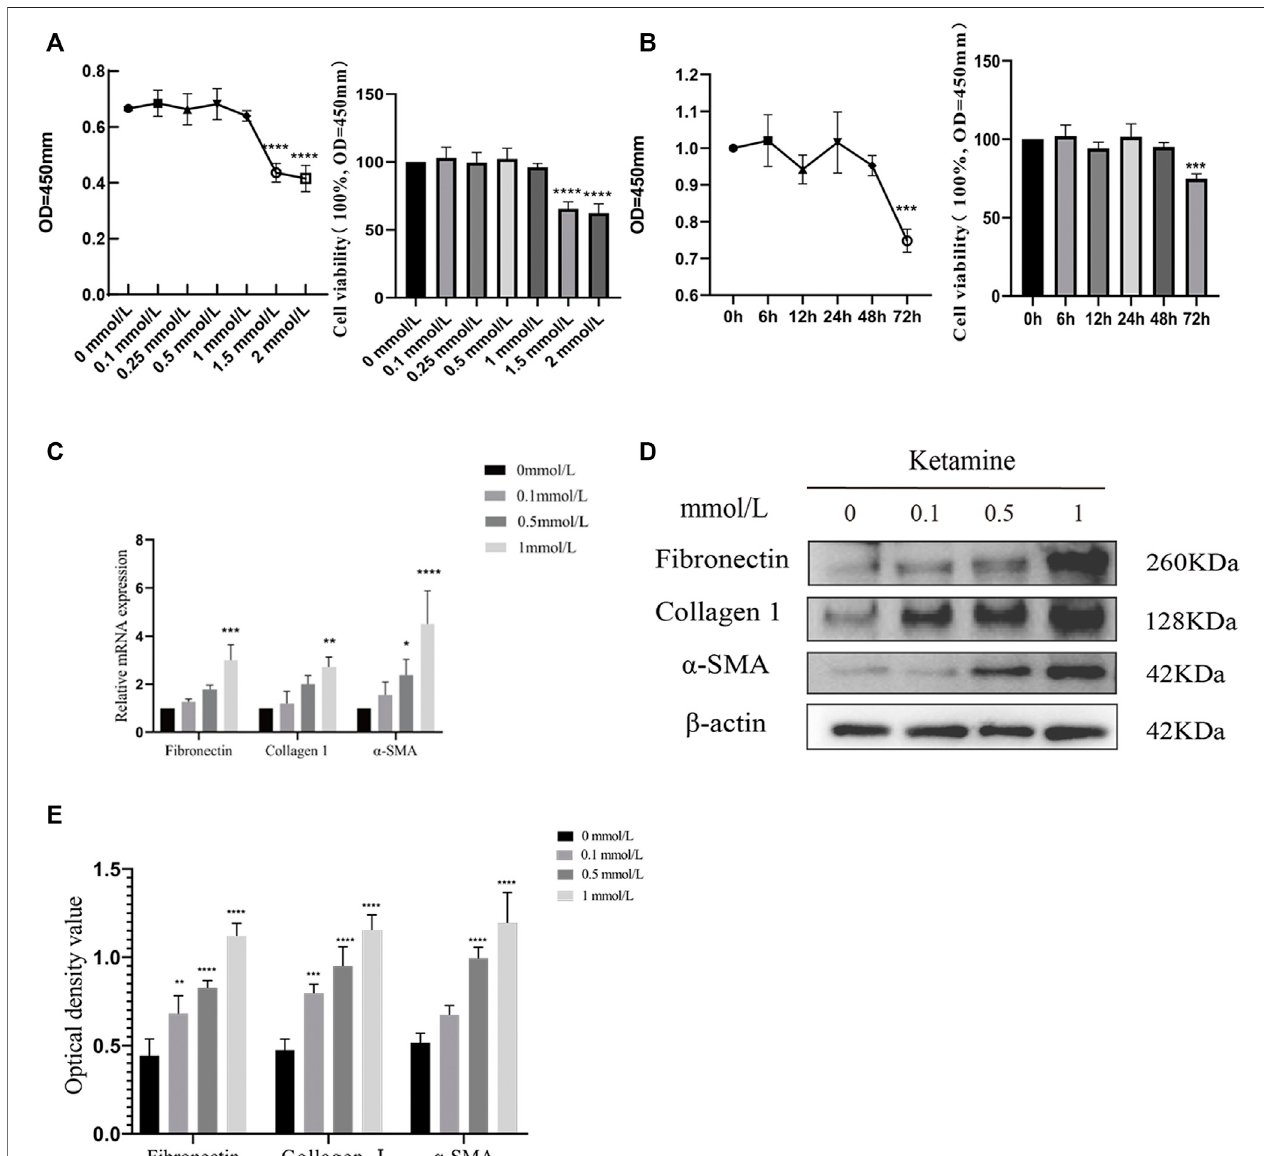
FIGURE 1 | Ketamine causes fi brotic changes in SV-HUC-1 cells. (A) The cytotoxicity of 48 h treated ketamine was tested by a CCK8 kit. When the concentration of ketaminereaches1.5 mmol/L,cellviabilitydecreasessigni fi cantly, ****p < 0.0001comparedwith0 mmol/L. (B) ThecytotoxicityofketaminewastestedbyaCCK8kitinatime- dependentmanner. When thetimeofketamine treatment reaches72 h, cell viabilitydecreasessigni fi cantly, ***p < 0.001 compared with timeless than 48 h. (C) RelativeRNA levelsasdeterminedbytheRT-PCR(treatedfor48 h). (D) RepresentativebandsfromWesternblotanalysesofthelevelsofthe fi bronectin,collagen Ⅰ , α -SMAproteininSV- HUC-1 cells afterbeing treated withdifferent concentrations of ketamine (treated for 48 h). (E) Relativelevels of the fi bronectin, collagen Ⅰ , α -SMAprotein compared to β -actin. * p < 0.05 compared with 0 mmol/L; ** p < 0.05 compared with 0 mmol/L; *** p < 0.001 compared with 0 mmol/L; **** p < 0.0001 compared with 0 mmol/L. N (cid:1) 3.